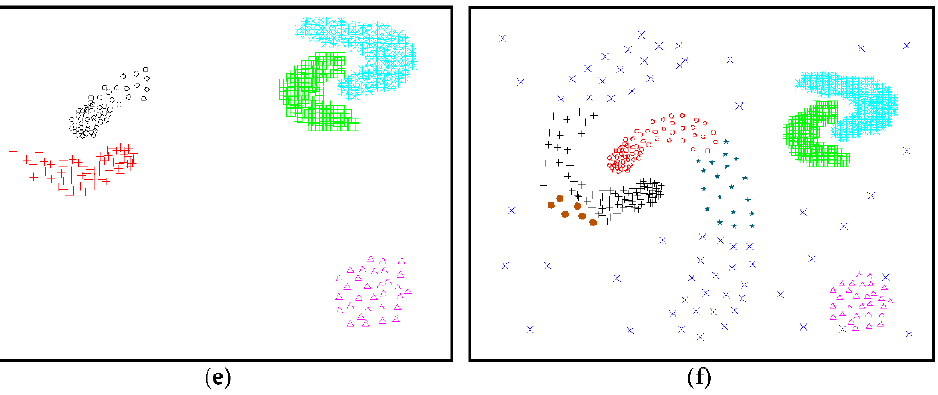
Figure 13. Clustering results of data set D3 by comparison: ( a ) Graph built by triangulation of D3; ( b ) clustering result by ASC; ( c ) clustering result by K-Means; ( d ) clustering result by DBSCAN; ( e ) clustering result by Žalik; and ( f ) clustering result by AMOEBA.